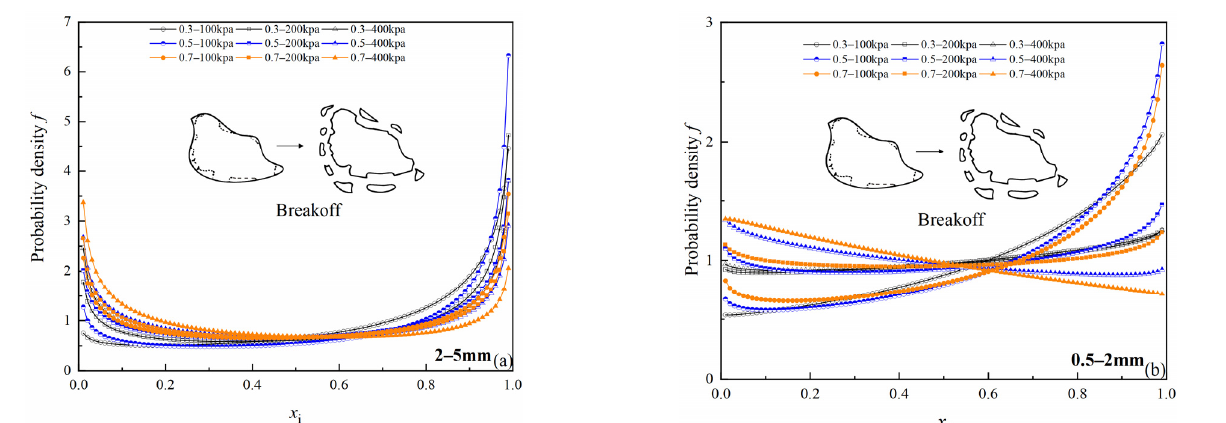
Figure 18. Variation of Hill probability density function f with different relative density ( Dr ) and confining pressure ( σ 3 ): ( a ) 2–5 mm particle groups; ( b ) 0.5–2 mm particle groups.